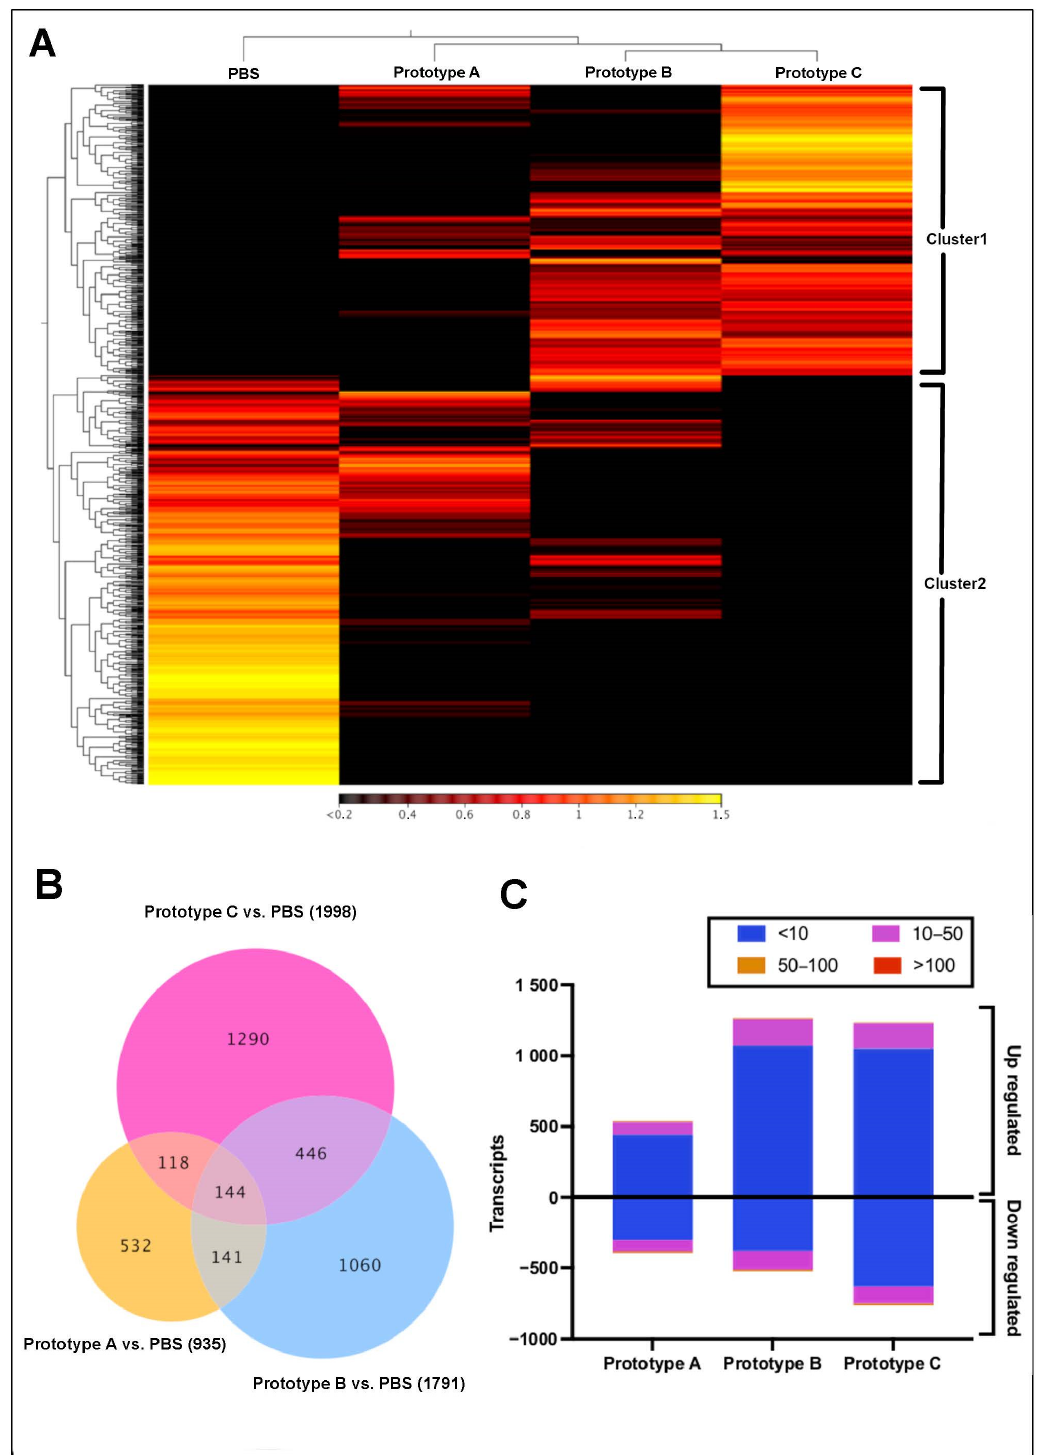
Figure 2. Transcriptomic profiling of S. salar head kidney tissue under experimental conditions. ( A ) Heatmap showing expression values expressed in TPM. ( B ) Venn diagram of contigs differentially expressed respect with the control group (false discovery rate (FDR) 4 and p -value 0.05). The number in parentheses represents the total contigs for each treatment. ( C ) Distribution of fold change values in each experimental group.